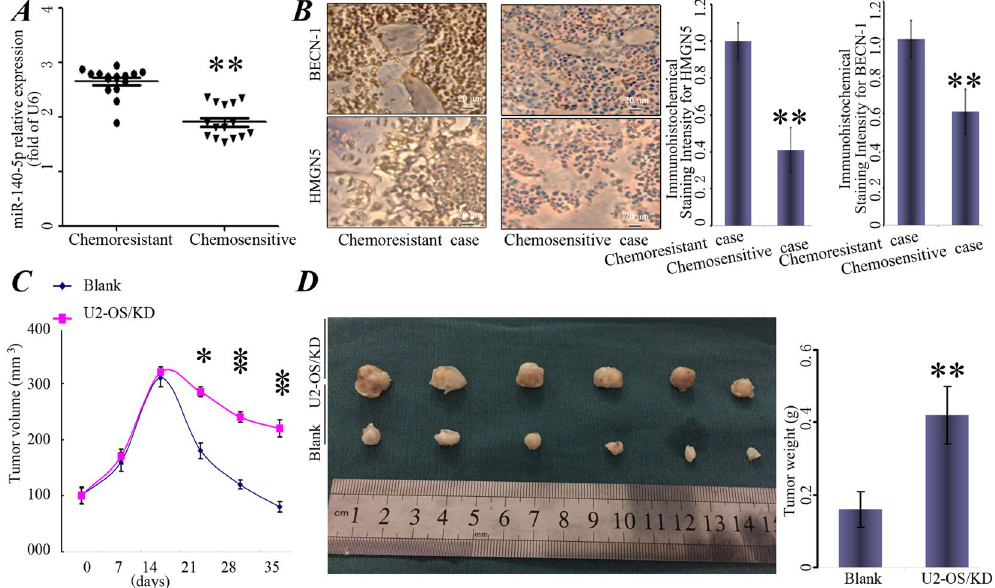
Figure 6. miR-140-5p is associated with chemoresistance and increased the chemoresistance. ( A ) miR- 140-5p expression was assessed in chemosensitive patients (n = 15) and chemoresistant patients (n = 15). ( B ) Representative photographs of IHC stained human osteosarcoma tissue specimens at a magnifcation of 200x. HMGN5 and BECN-1 were markedly up-regulated in chemoresistant patients. Columns, mean of intensity of the staining (n = 15). ( C ) The tumor volumes were calculated as V = length × width 2 /2 and measured at 1, 2, 3, 4, 5 weeks time points. ( D ) Representative photos for tumor isolated from the nude mice (n = 6). U2-OS/ KD cells or control cells (Blank) were transplanted in the left and right side of the mice, respectively. P < 0.05, ** P < 0.01 vs